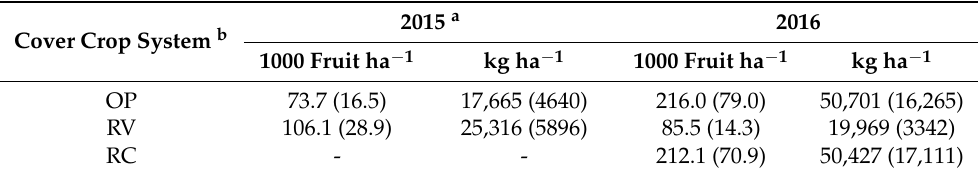
Table 3. Mean marketable organic yellow crookneck squash yield by cover crop system in 2015 2016. Numbers in parentheses represent one standard and 2016. Numbers in parentheses represent one standard error.